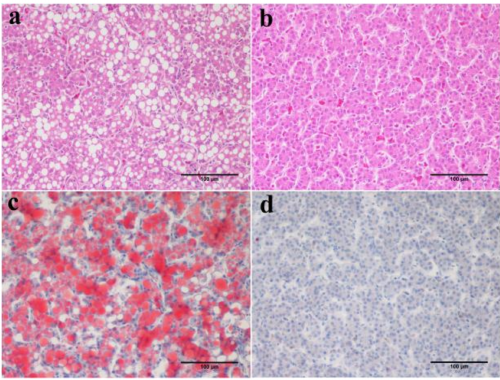
Figure 4. Typical H&E and oil red O stained liver sections (20 × ) from F1 generation of JXH chicken with or without fatty liver, paternal group ( a , c ); control group ( b , d ). Scale bar: 100 µ m.